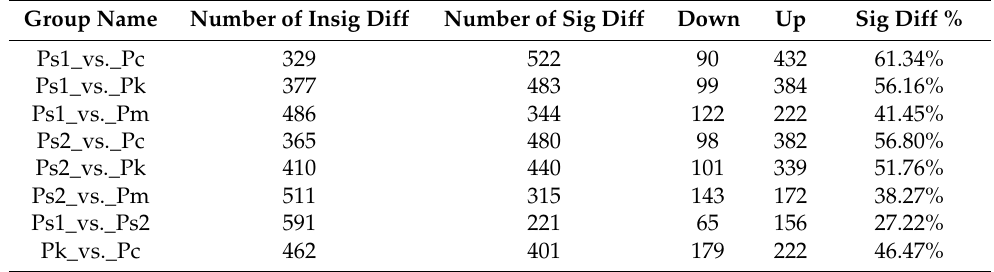
Table 4. Comparative analysis of differentially abundant metabolites among five seed